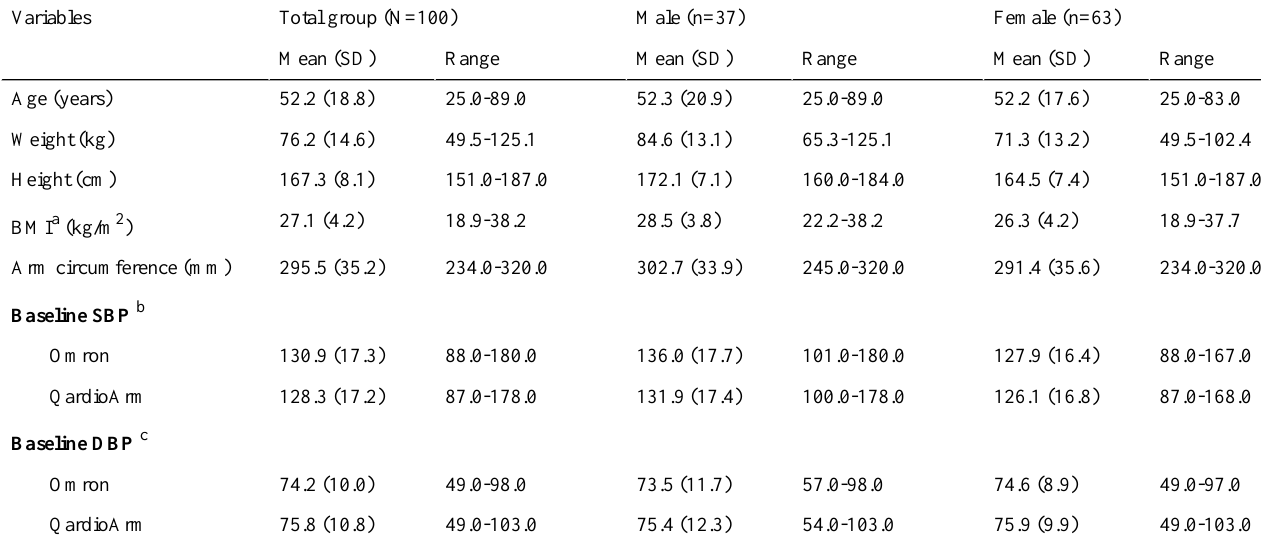
Table 1. Sociodemographic and clinical characteristics of the sample.